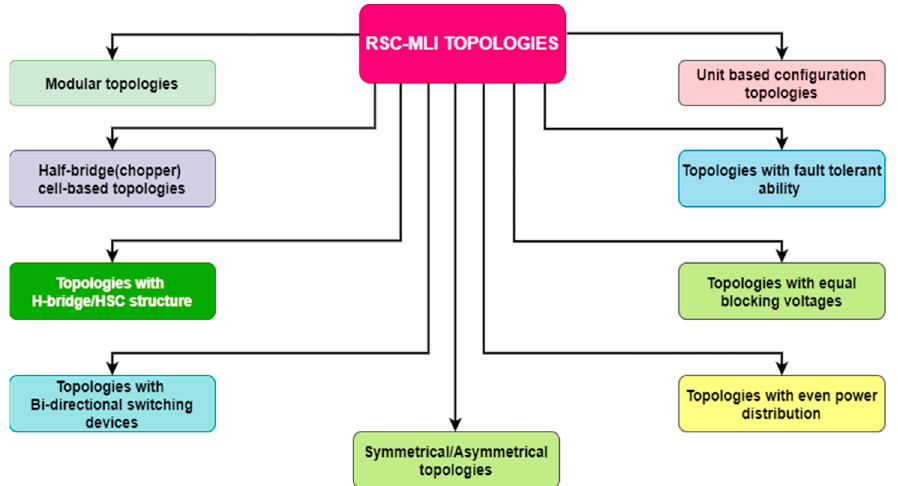
Figure 7. Classi fi cation of RSC-MLI topologies. Figure 7. Classification of RSC-MLI